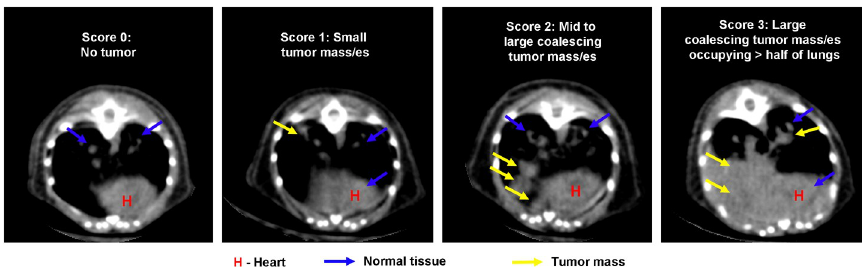
Fig 1. Representative images showing manual qualitative scores. A score of 0 contains no signs of tumor mass. The contrast in the lung space is derived from blood vessels and heart tissue. A score of 1 shows one or two small nodules within the lung field. A score of 2 shows more nodules that are beginning to coalesce, and a score of 3 shows a large coalescing mass that has infiltrated more than half the lung space.